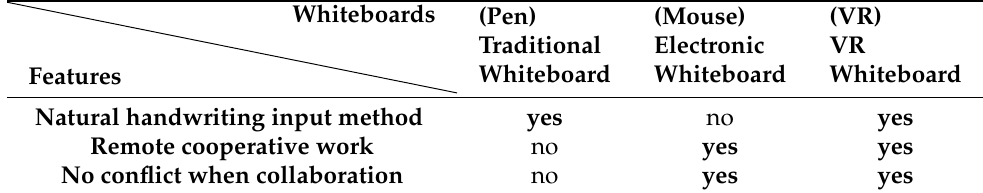
Table 2. Feature comparison of the three experiment scenes.